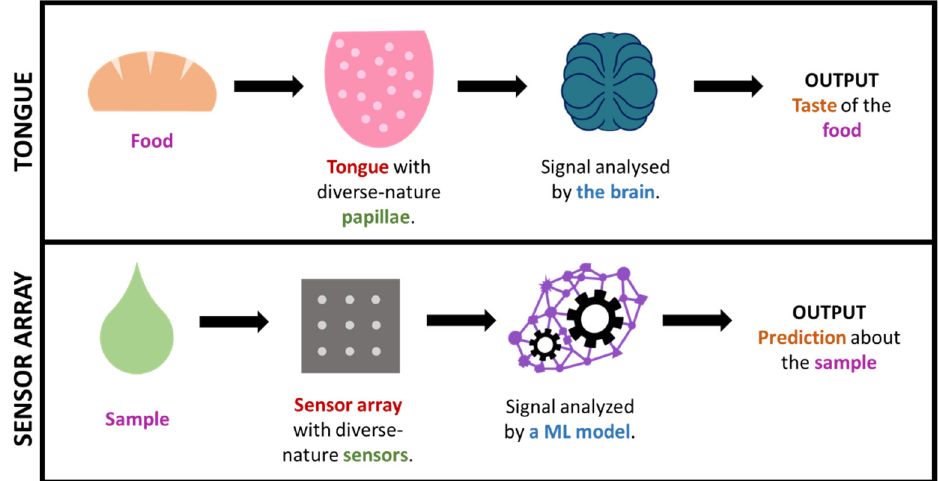
Figure 7. Simplified comparison of the sense of taste and a sensor array + ML technology.